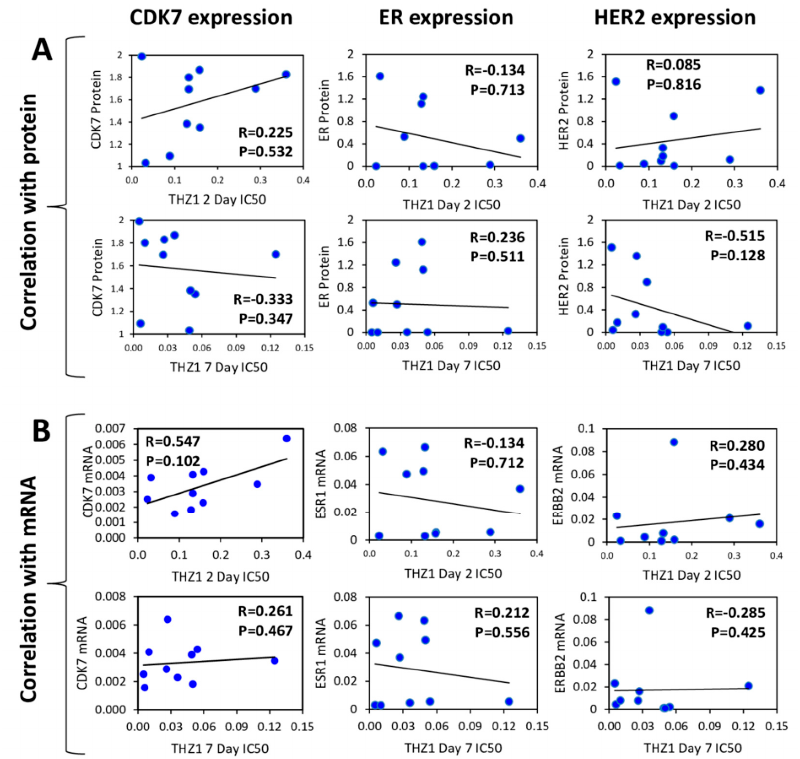
Figure 4. Correlations between CDK7, ER and HER2 expression in breast cancer cell line panel Bi-variant scattergraphs and Spearman rank correlations for CDK7, ER (ESR1) and HER2 (ERBB2) protein expression ( A ) and mRNA gene expression ( B ) levels compared to THZ1 2-day and 7-day IC 50 values across the cell line panel. Protein levels expressed as mean densitometric measurements normalized to α -tubulin protein expression on the same blot. mRNA levels expressed as mean relative expression (determined by RT-qPCR) normalized to GAPDH mRNA expression in the same sample.